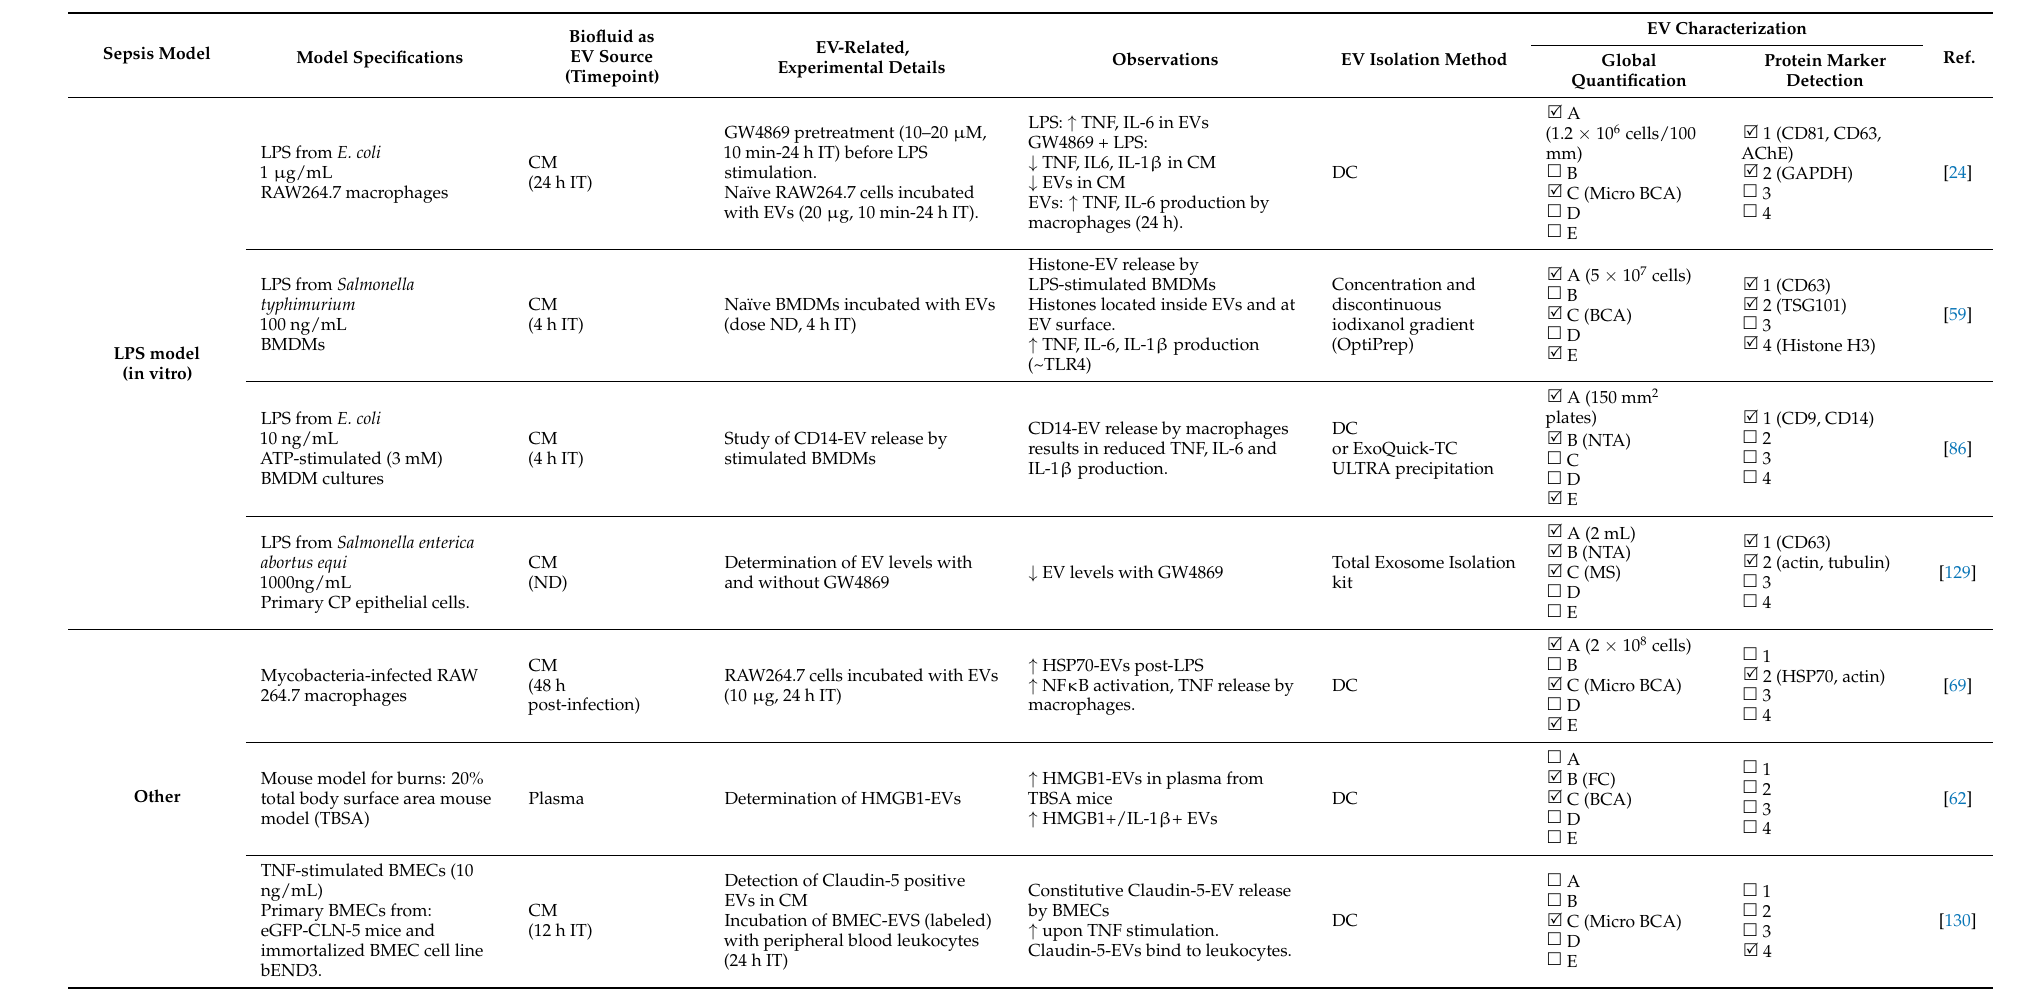
Rabbit-derived heart preparations incubated EV-induced nitric oxide production. Plasma with EVs (0.5 to 1× EV Induction of myocardial dysfunction. amount in plasma) ↑ PS-EVs Combination of prothrombin time, EC-derived CD105+ NA EVs and platelet count at D1 could predict DIC ab- sence. Total EV amount in same range for DIC and non-DIC patients. Specific EV source pattern in DIC patients. ↓ Platelet-derived EVs in DIC patients compared to non-DIC patients ↑ EC-EVs and leukocyte EVs in DIC (D1) ↑ Leukocyte- EVs in DIC at D7 No difference in EV levels between sepsis/septic shock patients and healthy